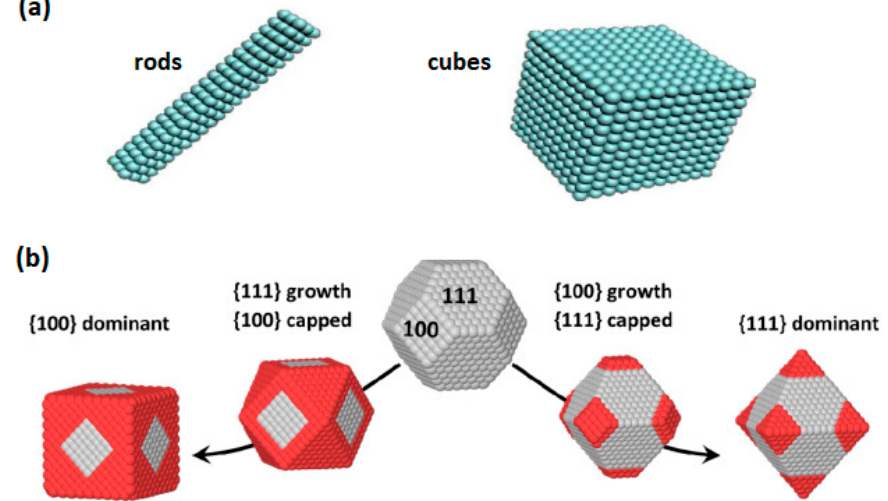
Figure 1. ( a ) Model shapes of rods and cubes. Reproduced with permission from Reference